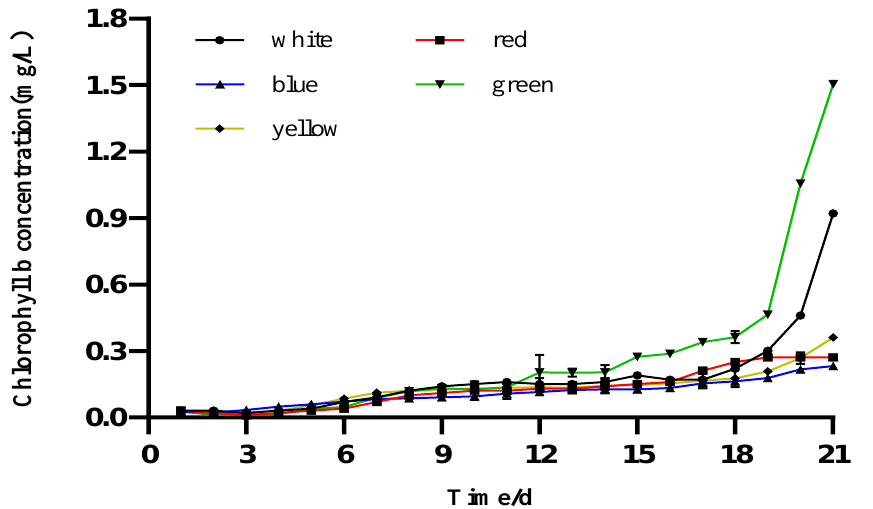
Figure 3. Daily mean values of chlorophyll- b in I. zhangjiangensis cultured under different colored LEDs (n = 3, p < 0.05 t -test).